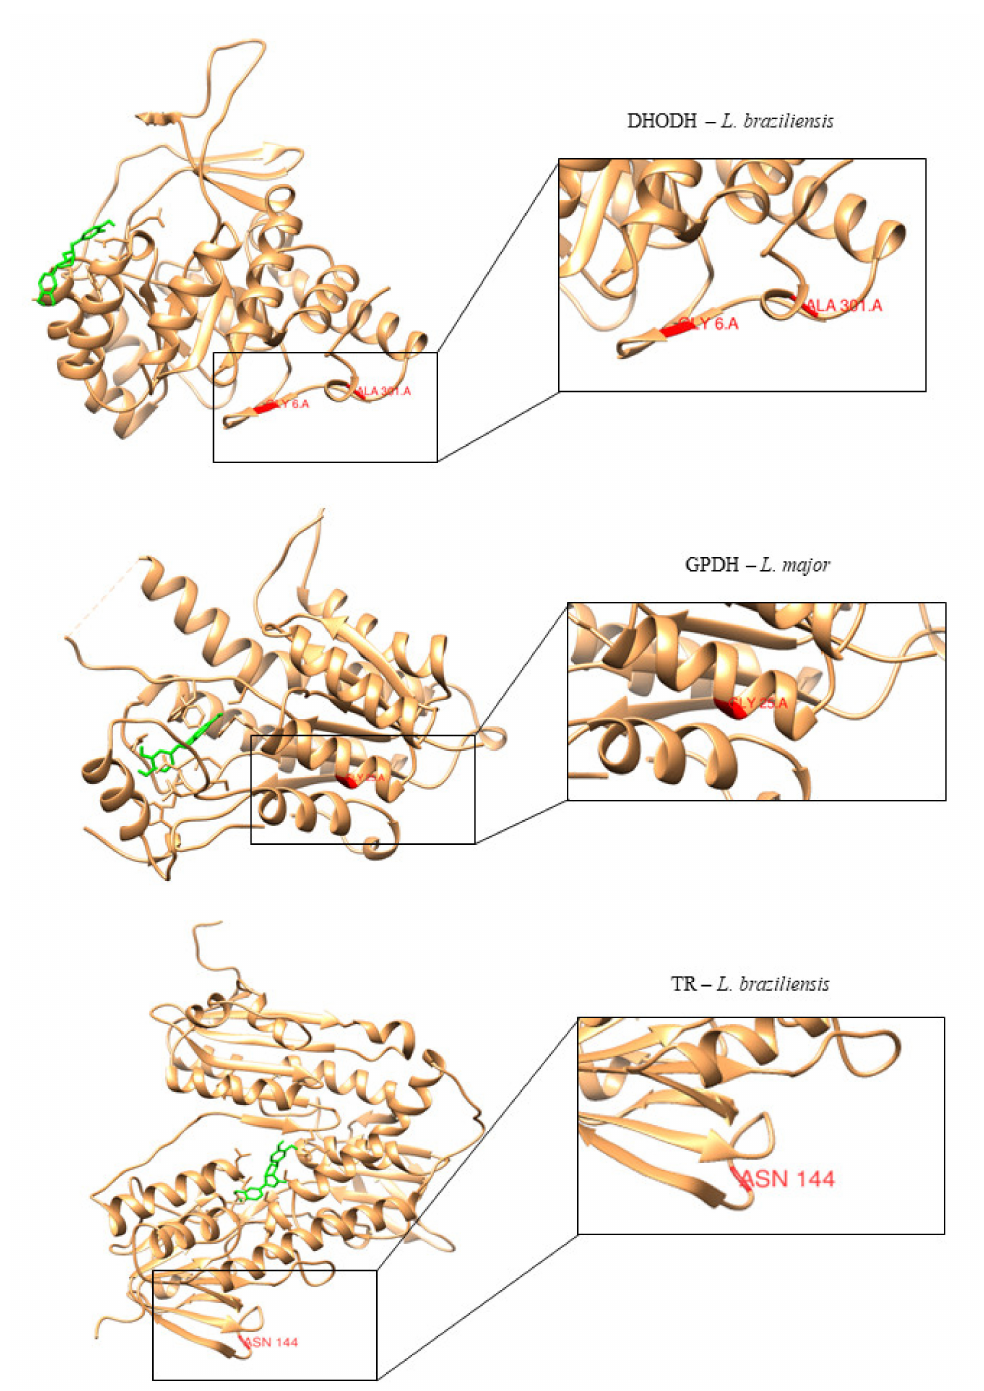
Figure 8. Three-dimensional structure of L. major and L. braziliensis enzymes. Amino acids that are likely to be a ff ected by SNPs are highlighted in red. Compounds located in the active site of their respective enzymes are highlighted in